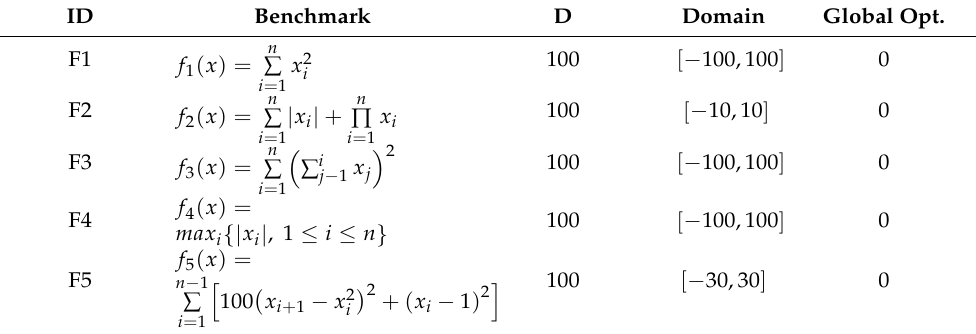
Table A1. Description of uni-modal benchmark functions.